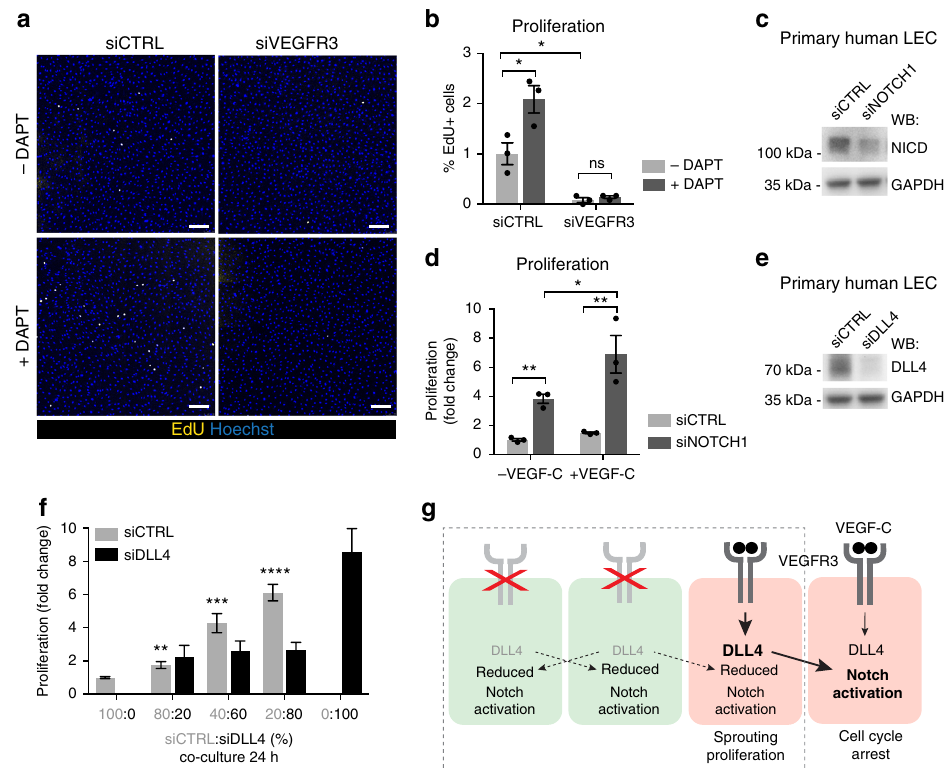
Fig. 7 Global and mosaic loss of DLL4 promote LEC proliferation through inhibition of Notch signaling in neighboring cells. a , b DAPT induced effect on the proliferation of control (siCTRL) or VEGFR3 (siVEGFR3) siRNA-treated LECs. a Tile scan immuno fl uorescence images and ( b ) quanti fi cation of proliferating EdU + LECs after 3 h of incorporation (mean ( n = 3 biological replicates) ± s.e.m). c Western blot analysis of cell lysates from LECs treated with siCTRL or NOTCH1 siRNA (siNOTCH1) and ( d ) quanti fi cation of proliferating EdU + LECs cultured with or without VEGF-C (data are normalized to the proliferation rate in siCTRL alone and represent mean ( n = 3 biological replicates) ± s.e.m). e Western blot analysis of cell lysates from LECs treated with siCTRL or DLL4 siRNA (siDLL4) and ( f ) quanti fi cation of proliferating EdU + cells in co-cultures of siCTRL and siDLL4 LECs mixed in different ratios (data are normalized to the proliferation rate in siCTRL alone and represent mean ( n = 6 biological replicates) ± s.e.m). g Model of cell-autonomous and non-cell- autonomous effects of VEGFR3 expression de fi ning LEC responses during sprouting lymphangiogenesis. VEGF-C-VEGFR3 signaling positively regulates DLL4 expression leading to activation of Notch and cell cycle arrest in neighboring LECs. VEGFR3 de fi ciency (green cell) consequently leads to downregulation of DLL4 and inhibition of Notch in neighboring LECs, but only VEGFR3 expressing (red) cells respond by proliferation and sprouting. When VEGFR3 − cells are in excess, VEGFR3 + cells interact predominantly with LECs with low DLL4 and respond by proliferation (dashed line) * P < 0.05, ** P < 0.01, *** P < 0.001, **** P < 0.0001. Two-tailed unpaired Student ’ s t test ( b , d , f ) or one-way ANOVA with Tukey ’ s post hoc test ( d ; comparison between VEGF-C untreated and treated groups). Scale bars: 200 µ m ( a ). ns: not signi fi